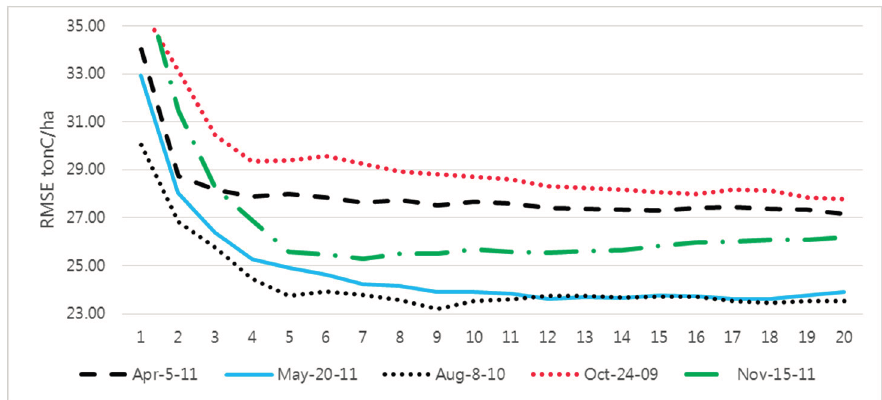
Figure 5. Changing of RMSE due to increase of